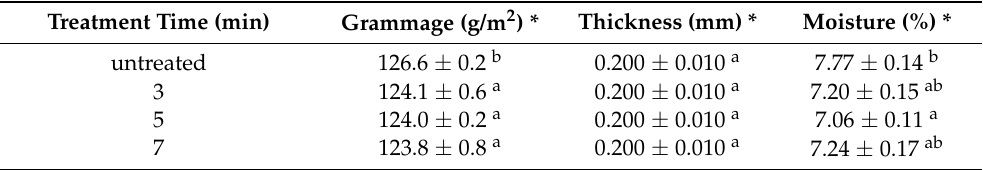
Figure 7. Effect of treatment time on water absorption of untreated and treated KPs with plasma at 200 mTorr and 50 Watts. Note: values indicated with the same letters are not significantly different at p < 0.05. Table 3. Effect of treatment time on grammage, thickness, and moisture content at 200 mTorr and 50